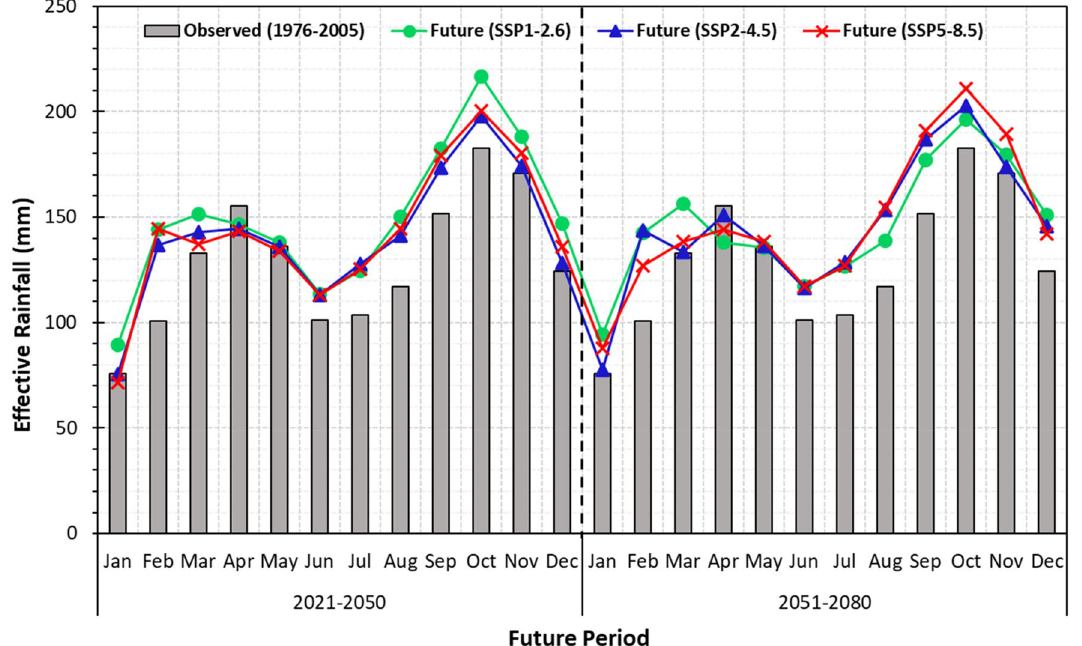
Fig. 10 Projected ensemble mean monthly effective rainfalls under SSP1-2.6, SSP2-4.5, and SSP5-8.5 scenarios for future periods 2021–2050 and 2051–2080 and with respect to baseline period of